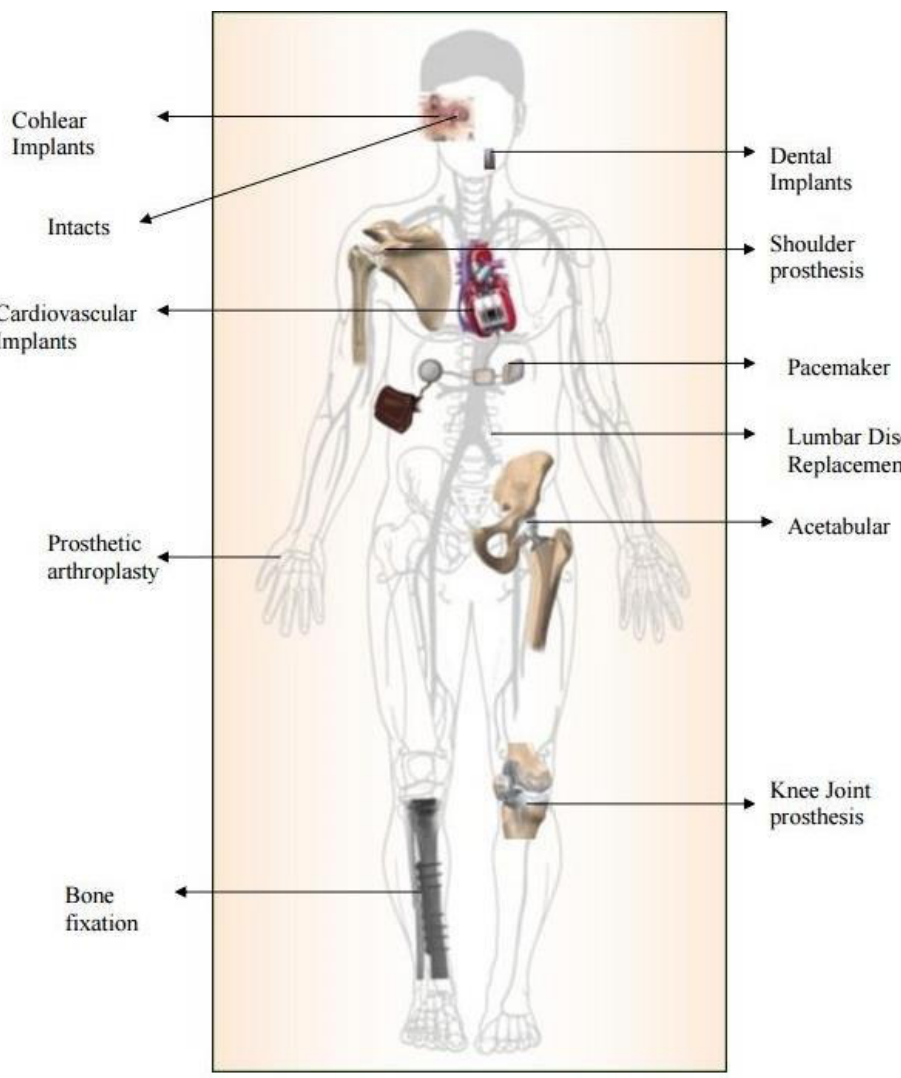
Figure 1. Application of metallic biomaterials as implants in different areas of the human body [39]. Reproduced with permission from Bentham Science Publishers.